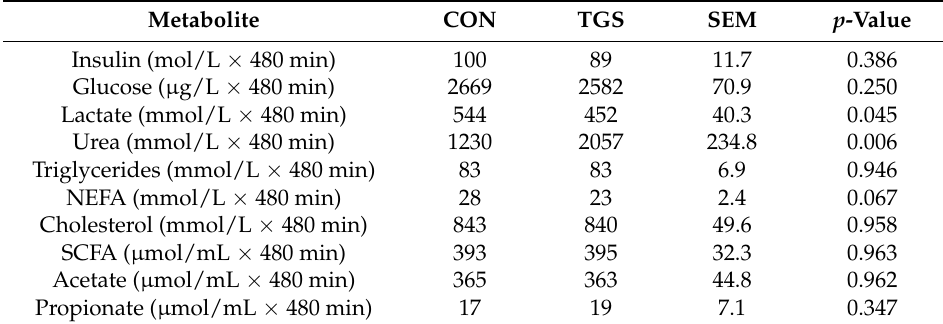
Table 5. Area under the curve values (0–480 min) during serial blood samplings of pigs fed transglycosylated (TGS) or control (CON) starch diets. Metabolite